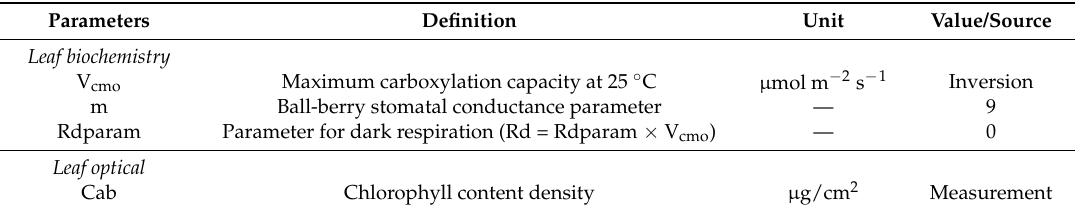
Table 1. Values or sources of the main input parameters of the SCOPE model used in our simulation